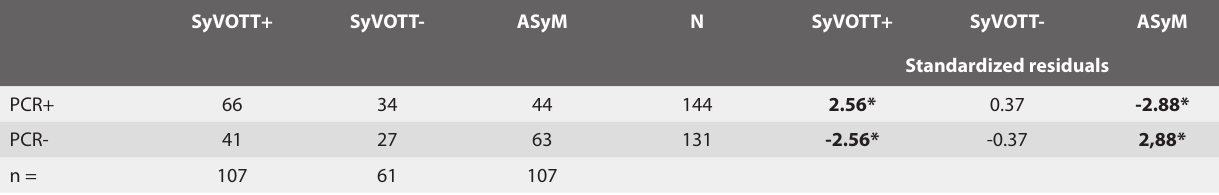
Table 2. Association of chemiosensorial impairment with RT-PCR molecular analysis. SyVOTT+